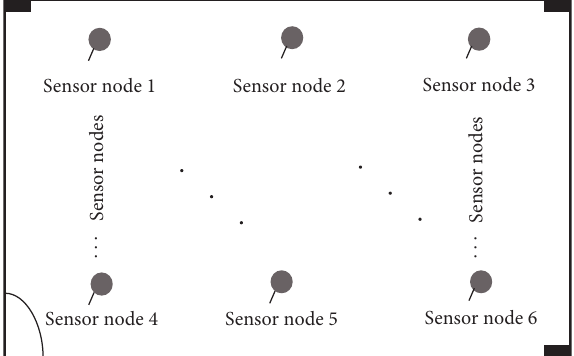
Figure 2: Schematic diagram of sensor node deployment for fire